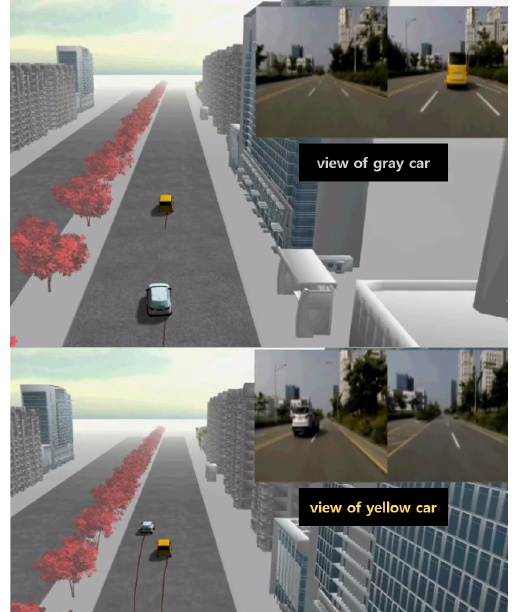
Figure 14. Traffic scene with two vehicles passing each